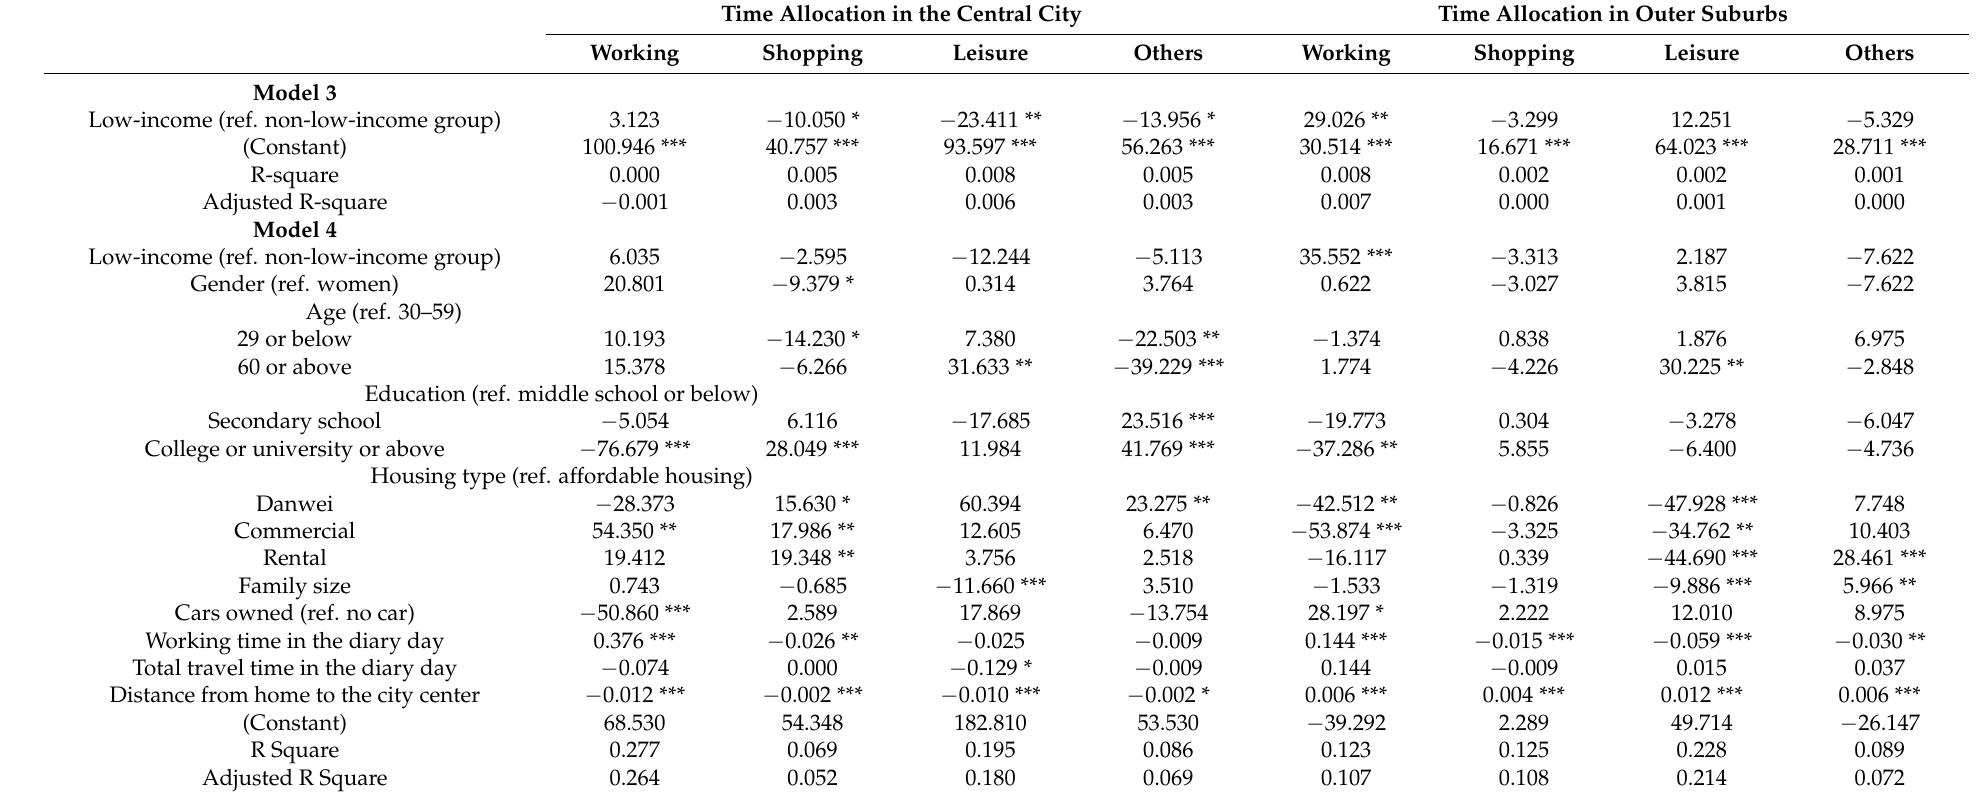
Table 8. Factors affecting the spatial distribution of individual activity time on